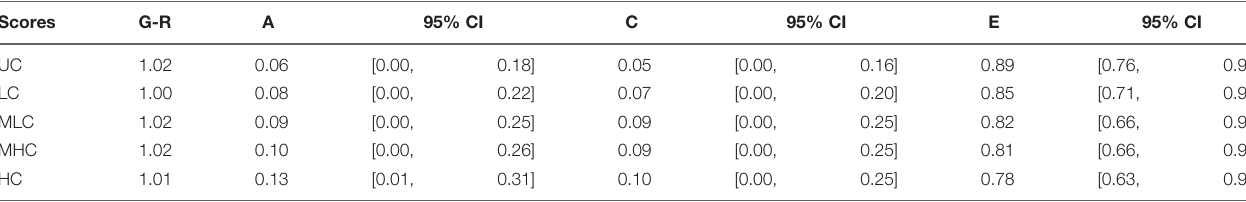
TABLE 3 | Genetic and environmental factor estimations in Bayesian ACE models in Study 1. Scores